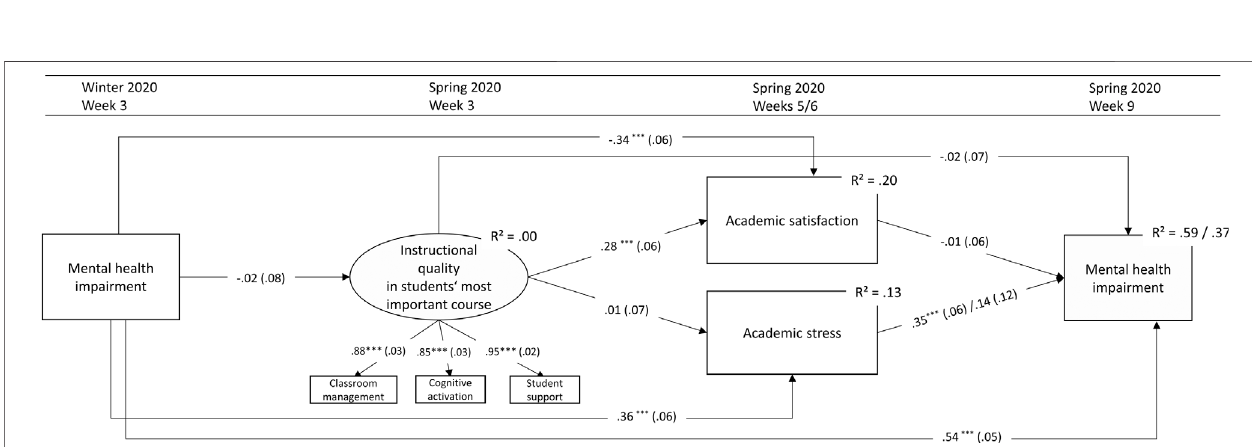
FIGURE 4 | Associations between Instructional Quality in Students ’ most Dif fi cult Course, Academic Beliefs and Mental Health Impairment Changes Across Gender(ModelB.1). Reported are standardized effects.Genderspeci fi c effects for female ( n (cid:1) 137) and male students ( n (cid:1) 62) are reported if the Wald χ 2 -test indicated meaningfuldifferencesineffects.Theorderofreportedgendereffectsis:female/males.Nogenderdifferencesexistifonlyoneeffectisvisualized. † p < 0.10,* p < 0.05,** p < 0.01, *** p < 0.001.